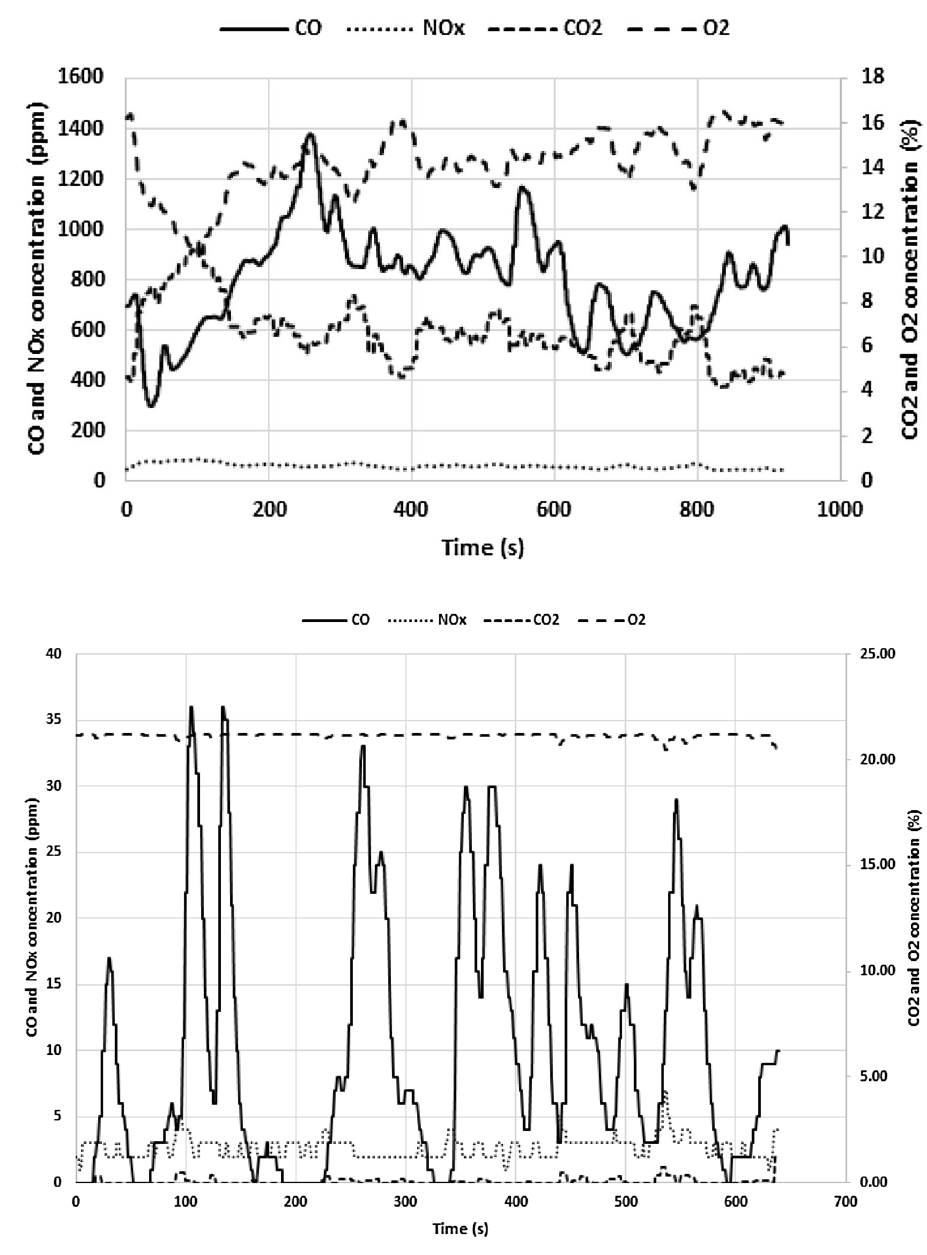
Fig. 6 CO (solid line, ppm, principal axis), NOx (dotted line, ppm, principal axis), CO (small hyphened line, %, 2 secondary axis) and O (large 2 hyphened line, %, secondary axis) emissions during a water ebullition test in the center of the combustion zone